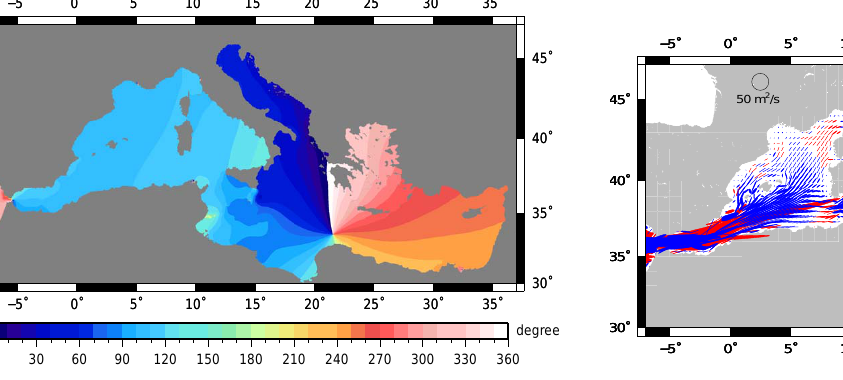
Fig. 12. Mapping of M2 constituent in the Gulf of Gabes from the empirical model EOT10a.